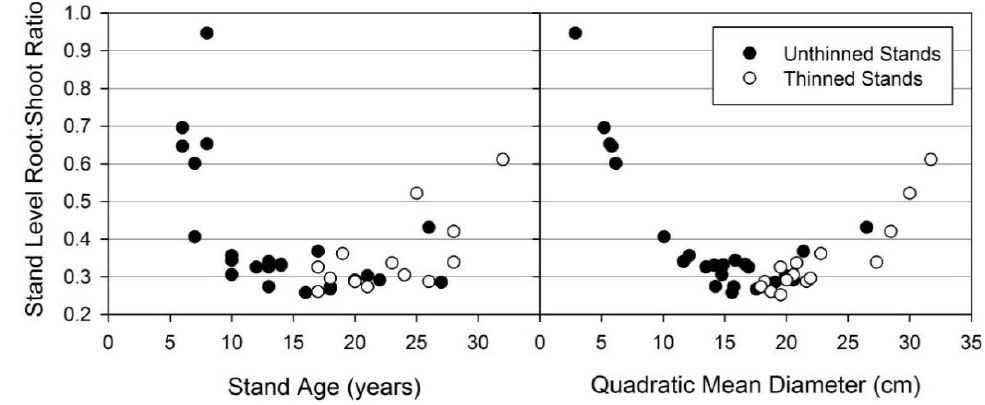
Figure 13. Root:shoot ratio of loblolly pine on reclaimed mineland at the stand level displayed by age and QMD (quadratic mean diameter). Thinned and unthinned stands are distinguished, but generally appear to have similar root:shoot